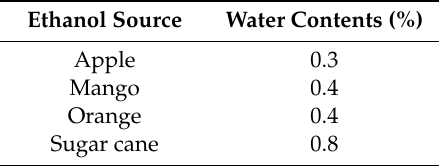
Figure 1. Fourier transform infrared spectroscopy (FTIR) spectra for the different obtained ethanols. Table 1. Water and oxygen contents for the different obtained ethanols.